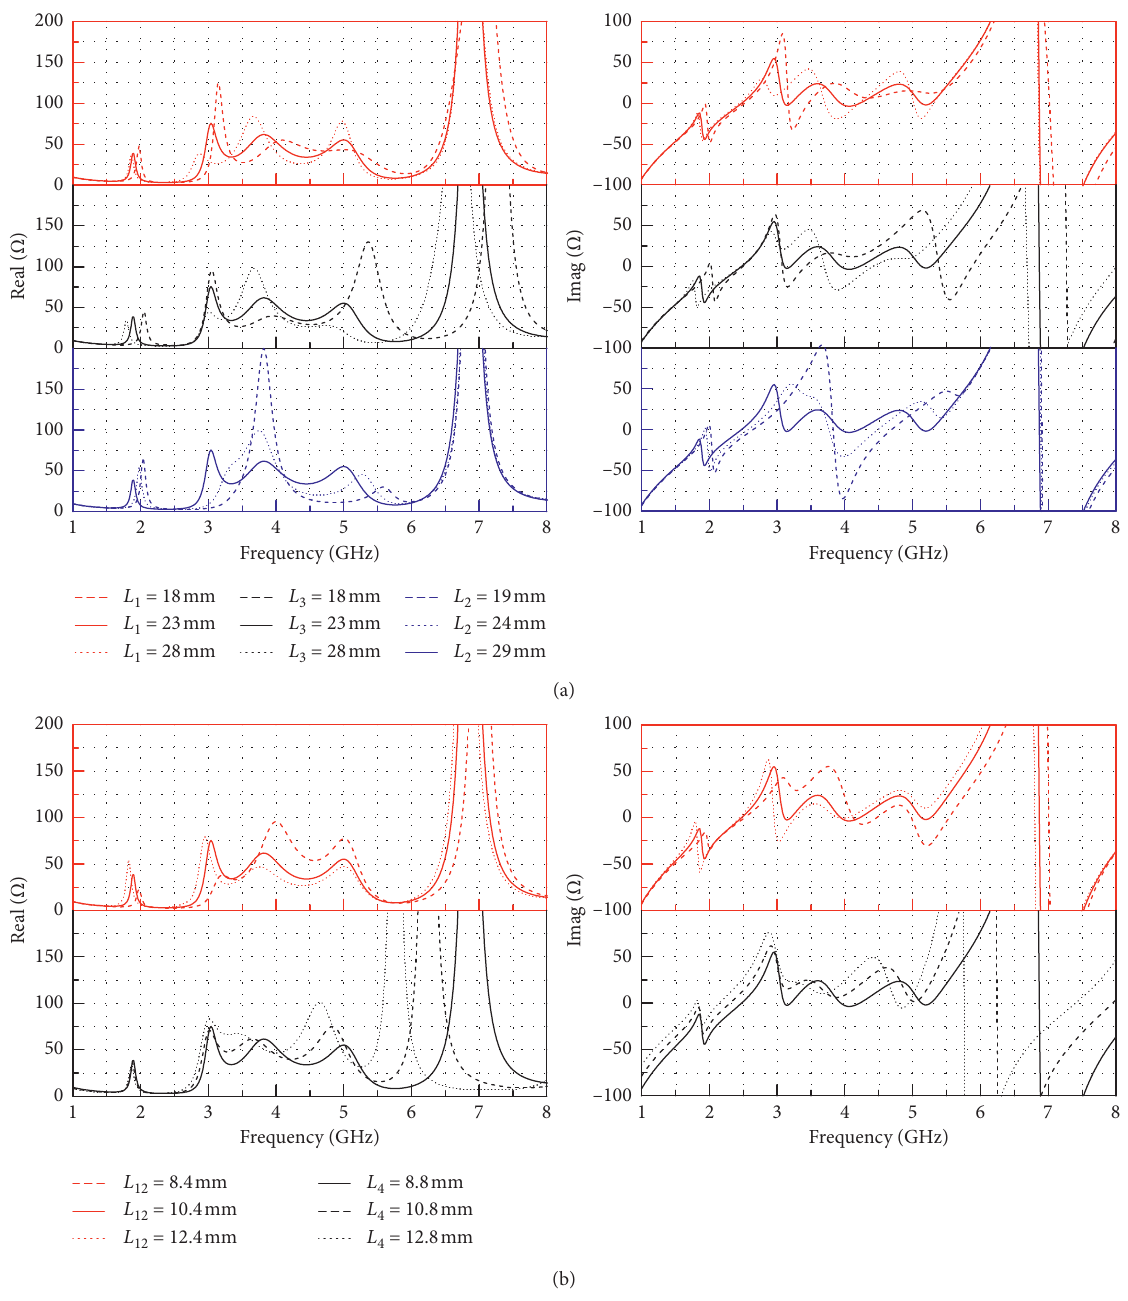
Figure 2: Parametric study of the input impedance (real part in the left column and imaginary part in the right column): (a) the effects of the patch length ( L 1 ), dipole length ( L 3 ), and slot length ( L 2 ) and (b) the effects of the balun slot ( L 12 ) and balun profile ( L 4 are − 26.93 dB, − 32.09 dB, and − 30.85 dB at 3.0 GHz, Figure 7. In general, the proposed antenna can maintain 3.6 GHz, and 4.8 GHz, whereas the measured values are − 22.00 dB, − 20.89 dB, and − 20.06 dB, respectively. The stable radiation patterns over the operating frequency band. The simulated half-power beam widths (HPBWs) at 3.0 GHz, 3.6 GHz, and 4.8 GHz are 60.58 ° , 63.46 ° , and 66.92 ° in the xoz -plane and 67.12 ° , 71.96 ° , and 69.03 ° in the yoz - plane, respectively. The measured values are 64.08 ° , 61.84 ° , and 67.07 ° in the xoz -plane and 68.36 ° , 67.62 ° , and 71.50 ° in the yoz -plane, respectively. The simulated crosspolarizations